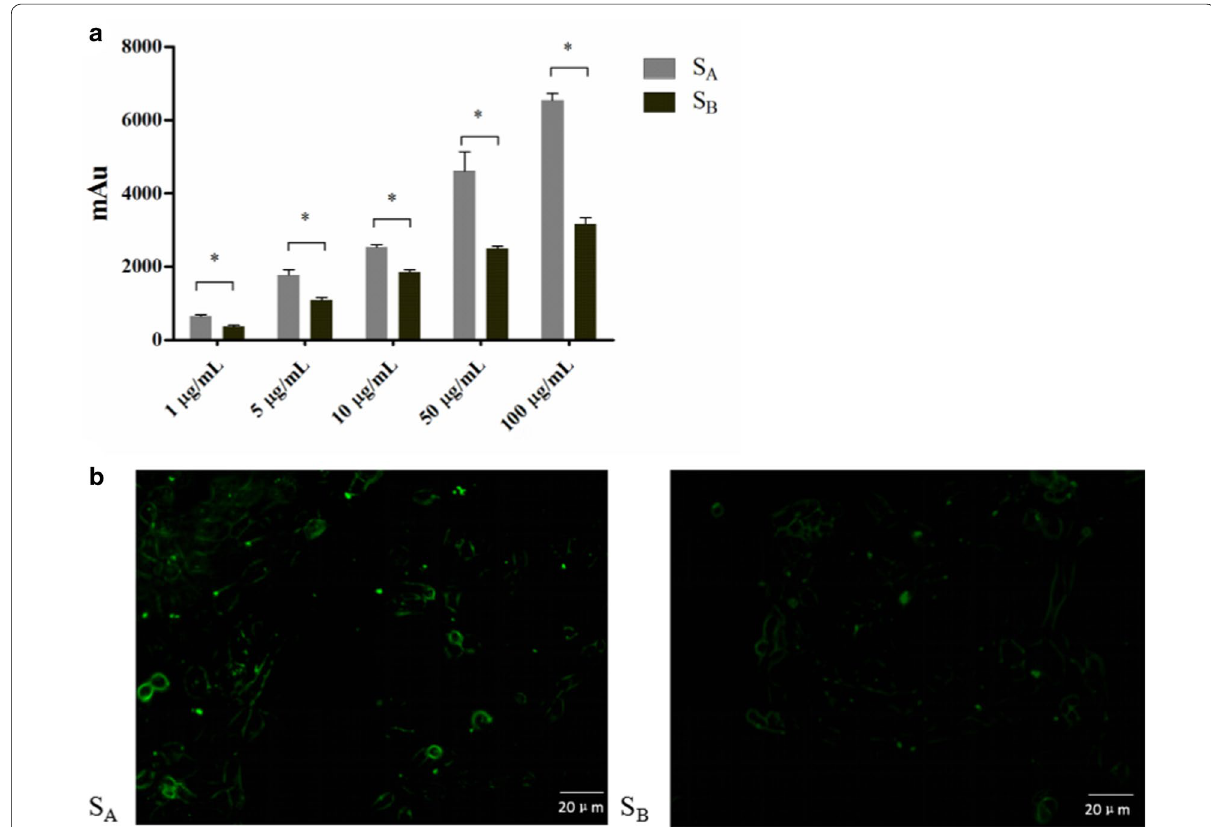
Fig. 5 Analysis of two S-layer proteins’ adherence to Caco-2 cells. a Analysis of two S-layer proteins’ adherence to Caco-2 cells by microplate reader fluorescence assay. b Analysis of two S-layer proteins’ adherence to Caco-2 cells by laser confocal